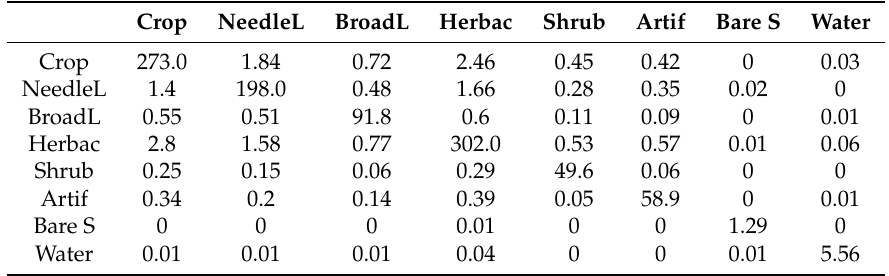
Table A13. Confusion matrix for the reference with errors proportional to (j,k) class frequencies and overall accuracy of 98%. Crop NeedleL BroadL Herbac Shrub Artif Bare S